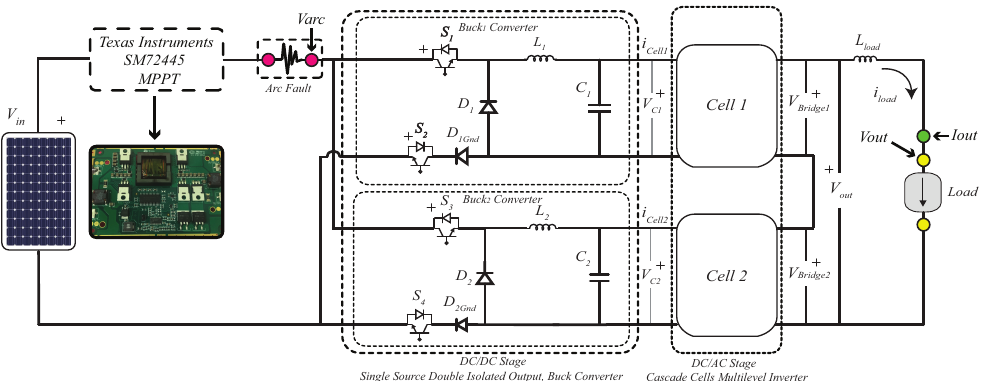
Figure 17. Schematic diagram for AF testing with the AF after the MPPT module.